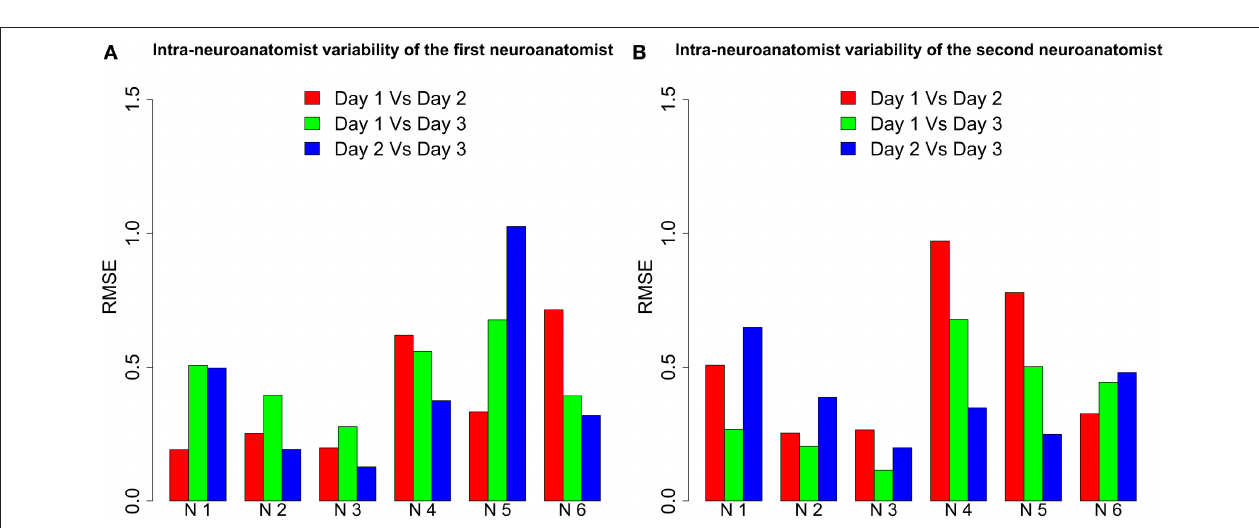
FIGURE 10 | RMSE between the somata extracted from six neurons by both neuroanatomists on three different days. We denote each neuron by N followed by a number. (A) For the first neuroanatomist, intra-neuroanatomist variability was high for Neurons 4, 5, and 6, whereas Neurons 2 and 3 were quite accurately segmented. (B) For the second neuroanatomist Neurons 4 and 5 stand out from the others because of their higher variation. Again Neurons 2 and 3 were the most accurately segmented.